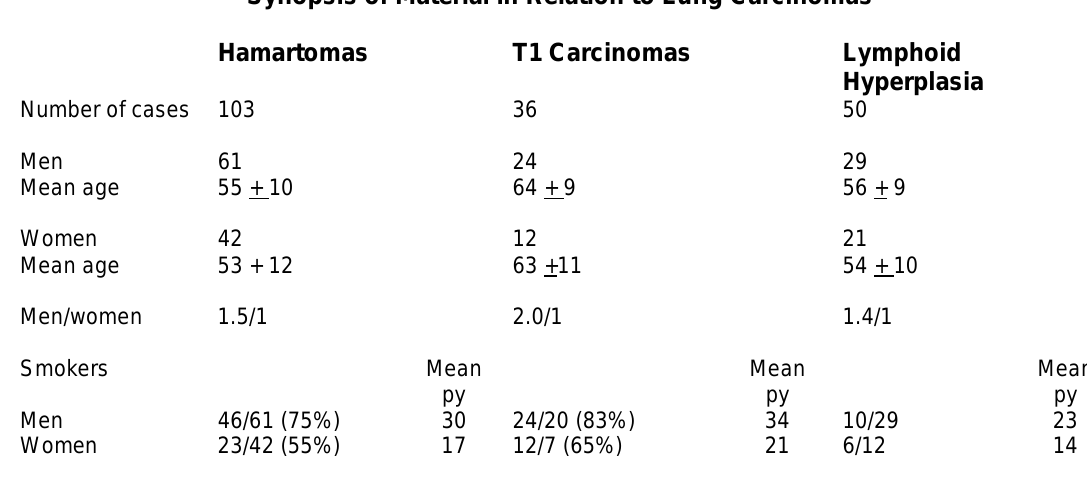
Synopsis of Material in Relation to Lung